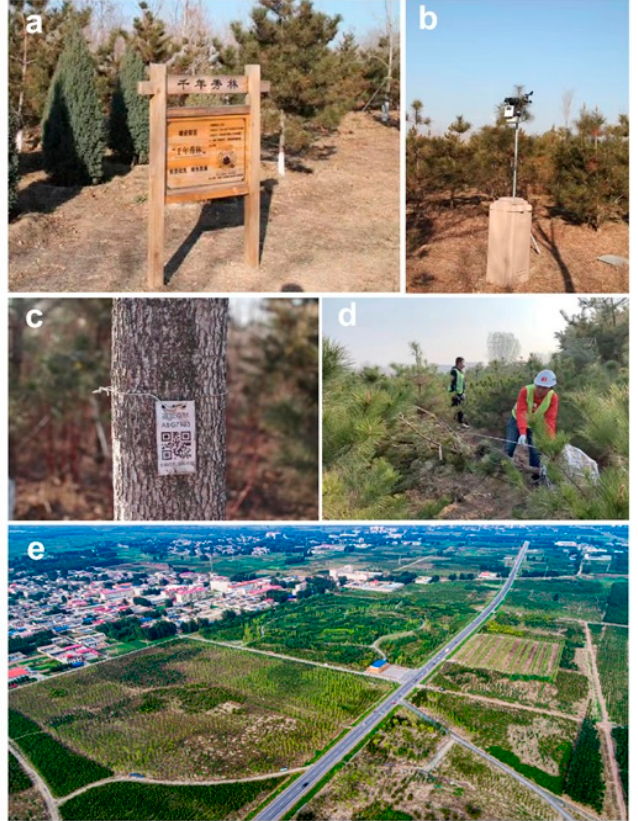
Figure 1. District map of Xiongan New Area in China. Xiongan New Area is located in the central region of “Jing-Jin-Ji” region, situated 120 km from Beijing and 110 km from Tianjin. It mainly includes Xiongxian, Anxin County and Rongcheng County with an area of 2000 km 2 .